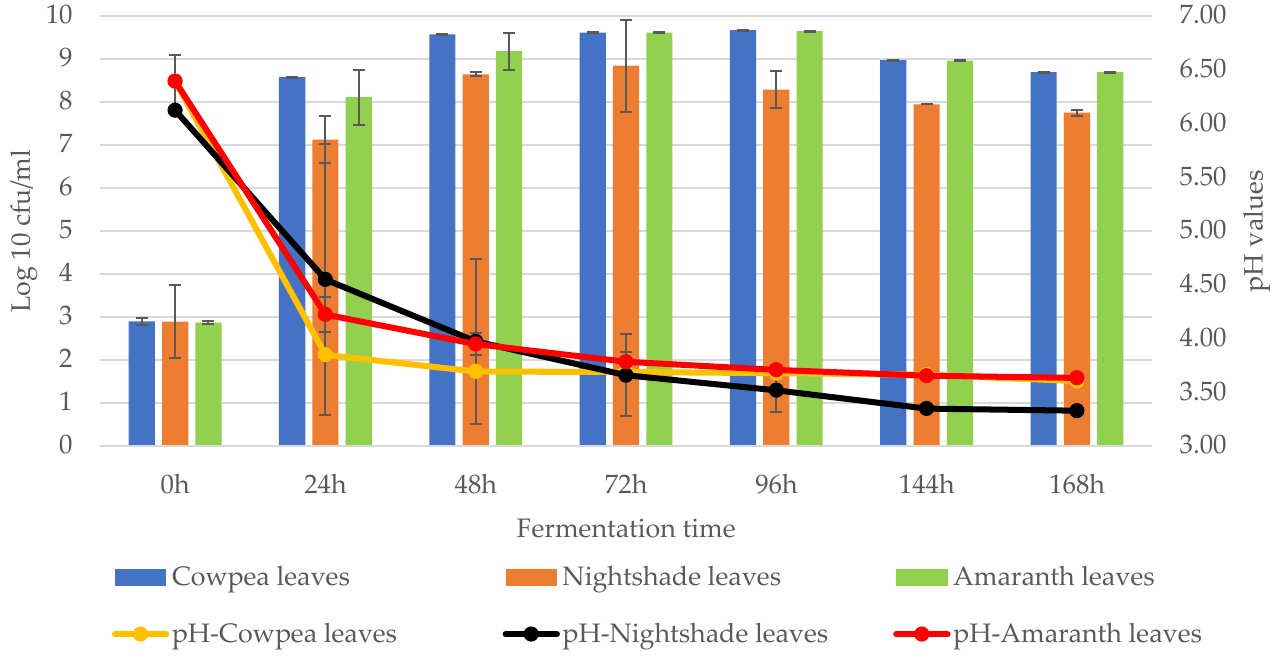
Figure 1. Lactic acid bacteria viable counts and pH determination from Kenya’s three commonly consumed African indigenous vegetables. The counts and pH values were determined in duplicates; the standard deviations are indicated.